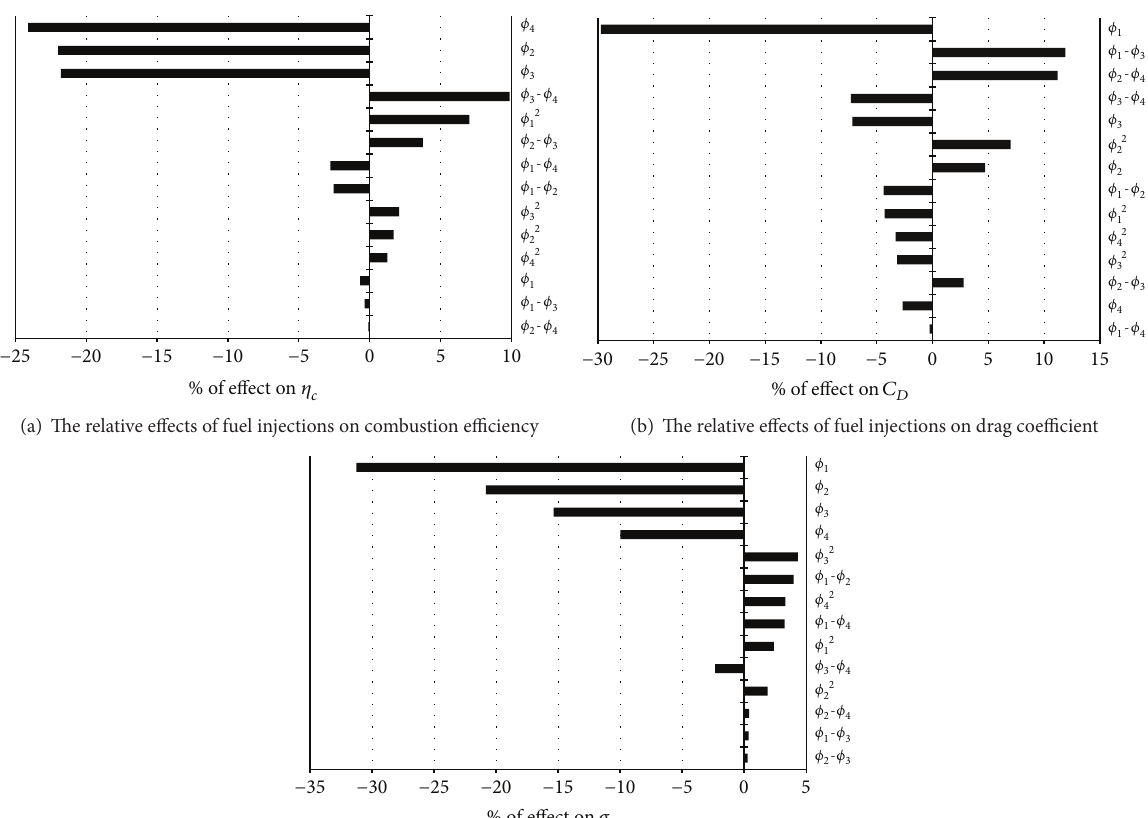
Figure 12: Main effects of the design variables on the objective functions.